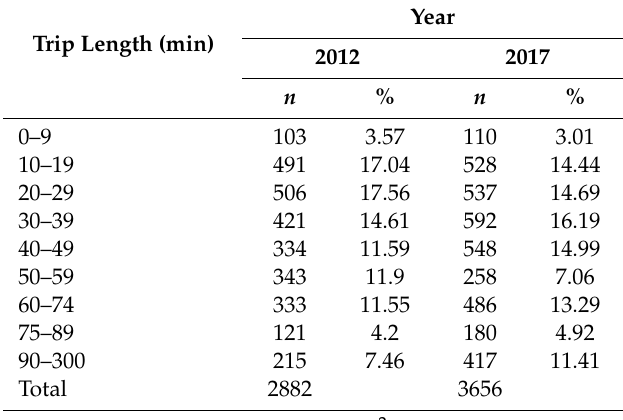
Table 4. Trip length in minutes in 2012 and